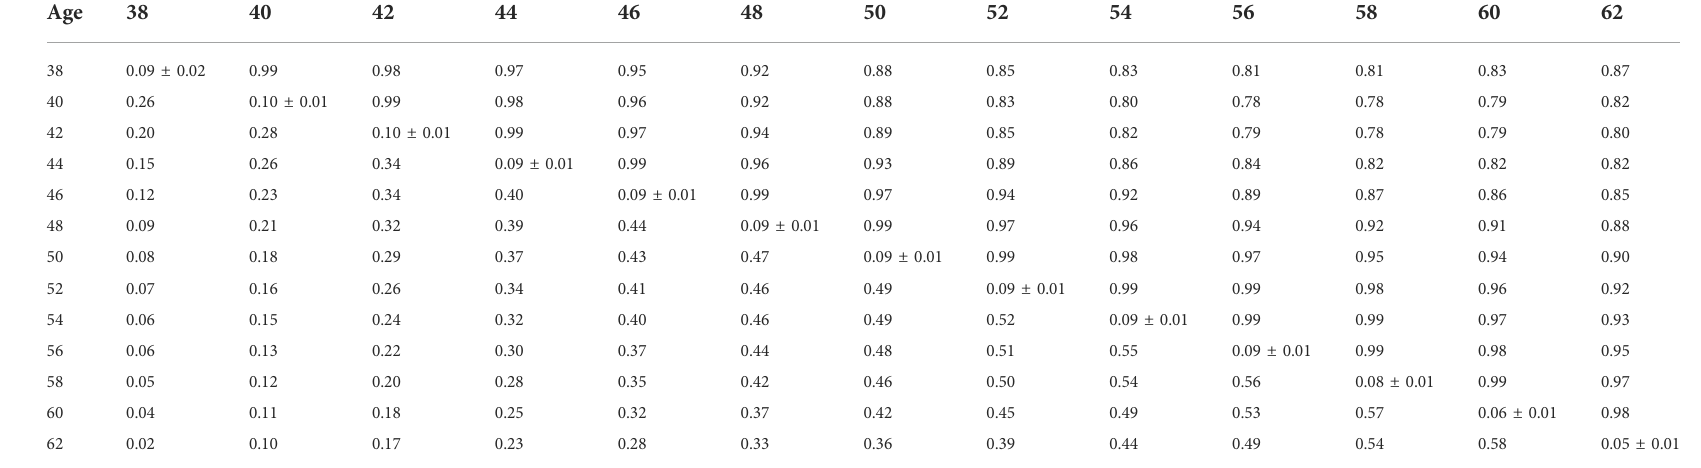
TABLE 6 Estimates of heritability (diagonal), phenotypic correlations (below diagonal), and genetic correlations (above diagonal) for fertility (FERT) using the ssGBLUP random regression model.